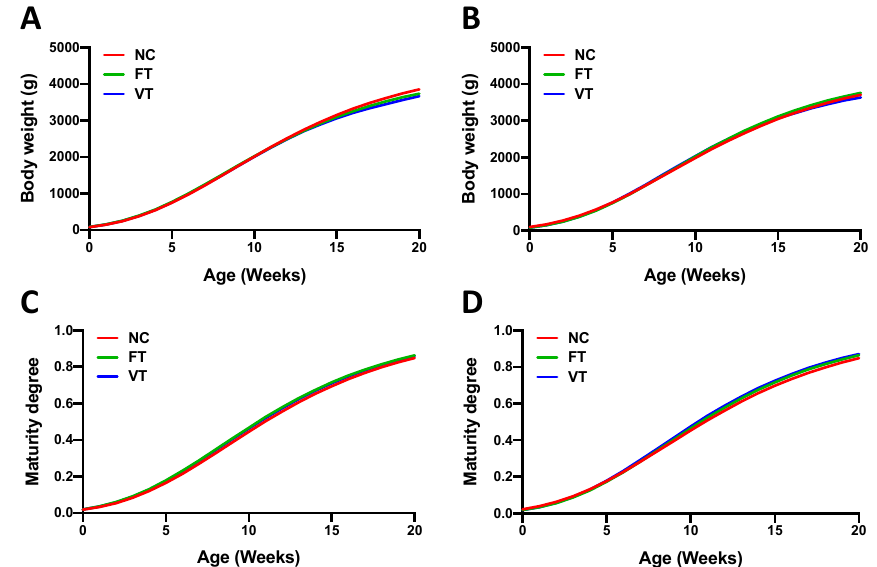
Figure A1. Gompertz curves comparing the growth between naturally conceived (NC), fresh-transferred (FT), and vitrified-transferred (VT) progenies of the ( A ) paternal crossbred generation and ( B ) maternal crossbred generation. Maturity curves of the NC, FT, and VT progenies of the ( C ) paternal crossbred generation and ( D ) maternal crossbred generation.